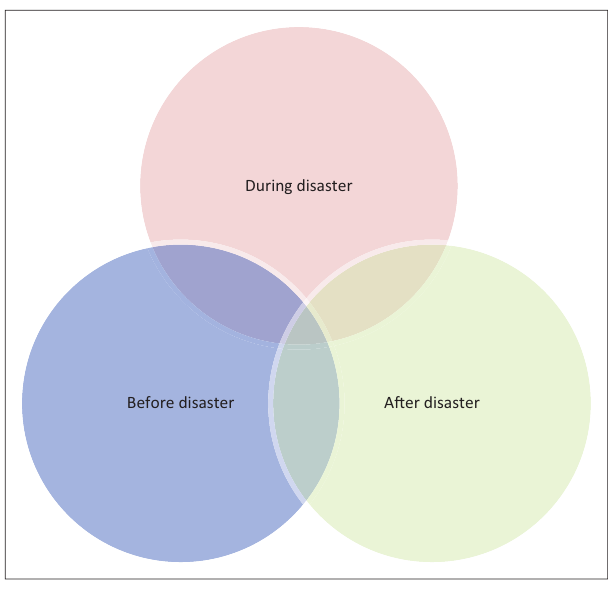
FIGURE 3: Identification of key actors in providing assistance in the disaster – Overlapped